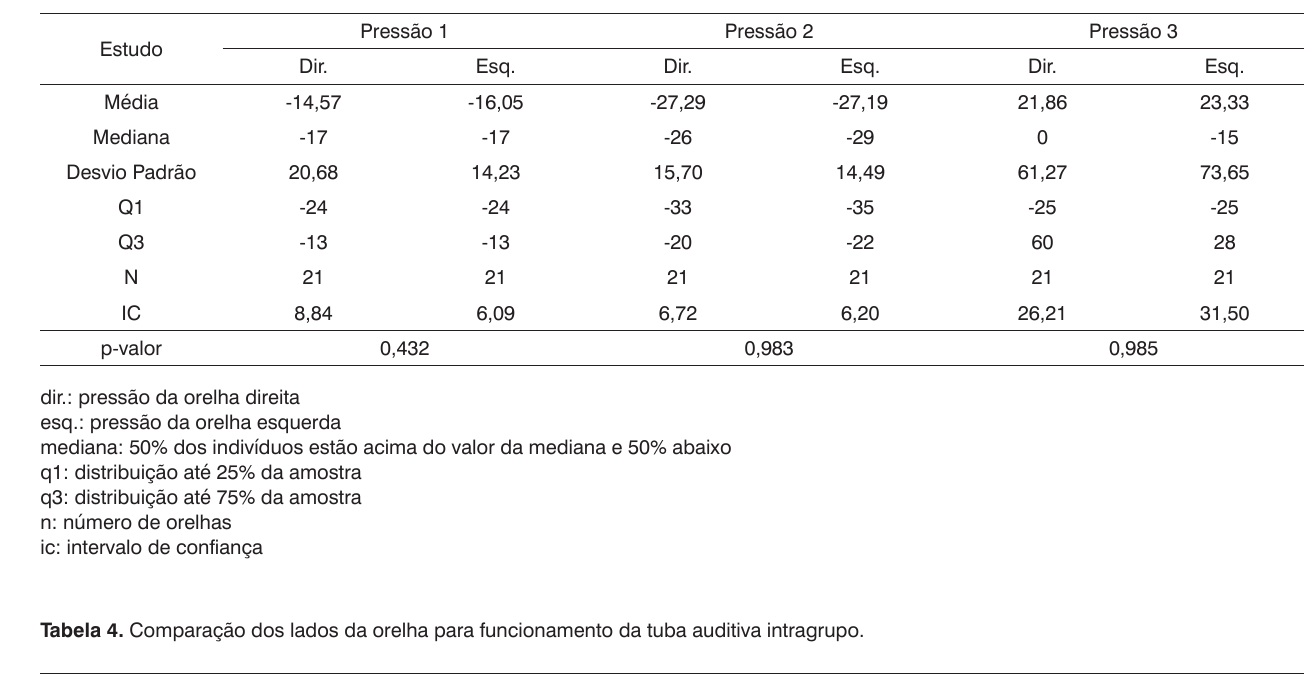
Funcionamento da tuba